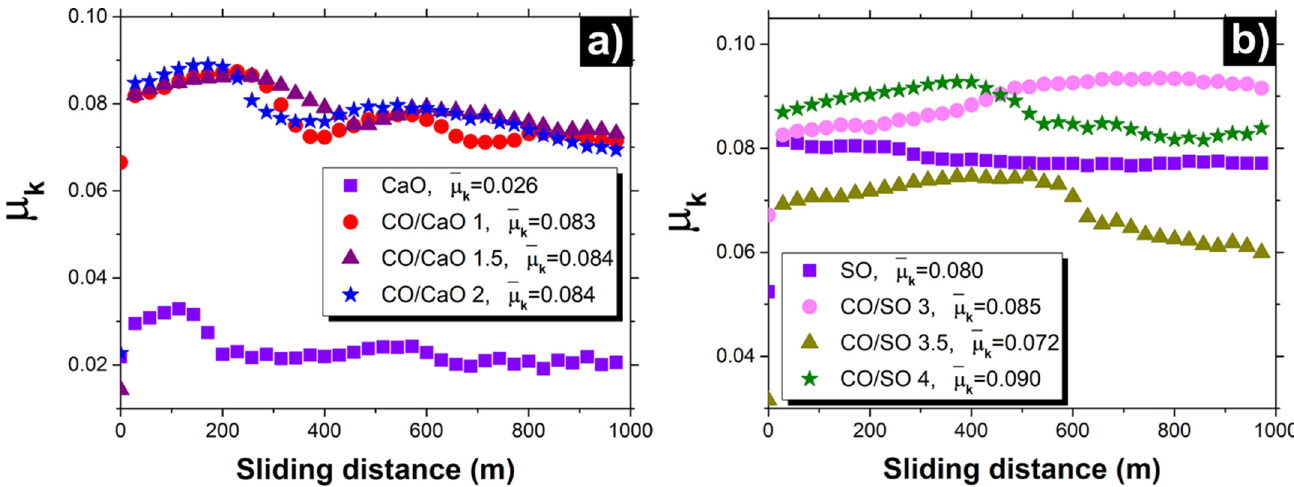
Figure 5. Influence of CO/CaO ( a ) and CO/SO ( b ) binary oil mixtures as green lubricants in the kinetic friction coefficient ( µ k ) of the 100Cr6/8620 steel system.